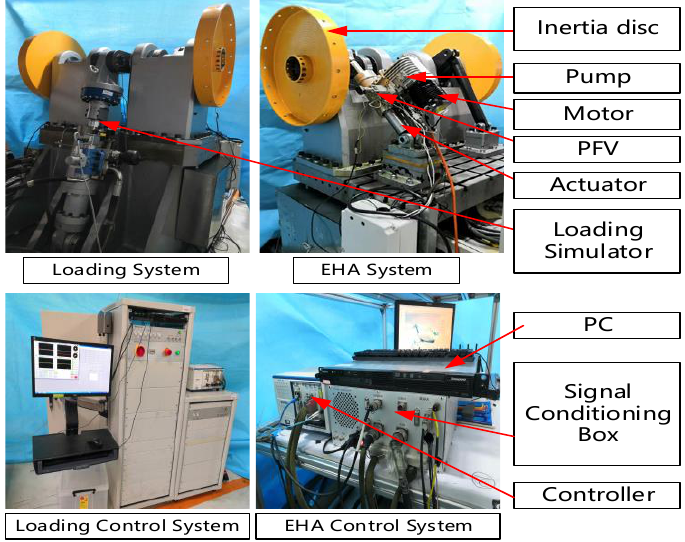
Figure 16. Test Bench For the EHA.